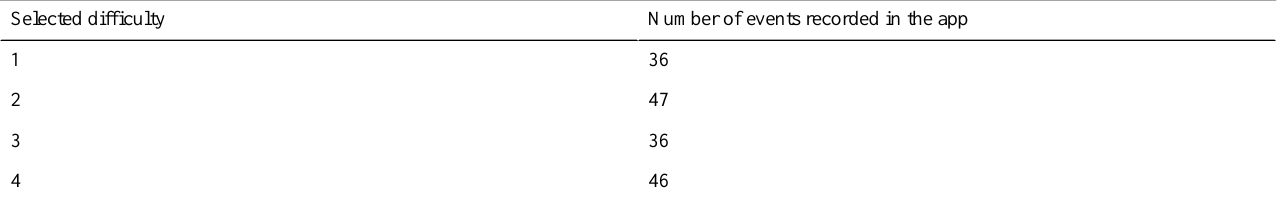
Table 3. Frequency for difficulty values selected by the experiment group.